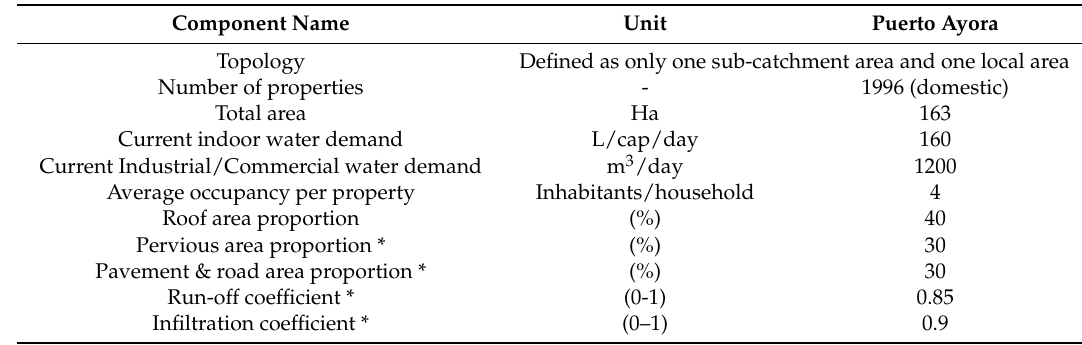
Table 3. Input information for the WM 2 model sub-catchment